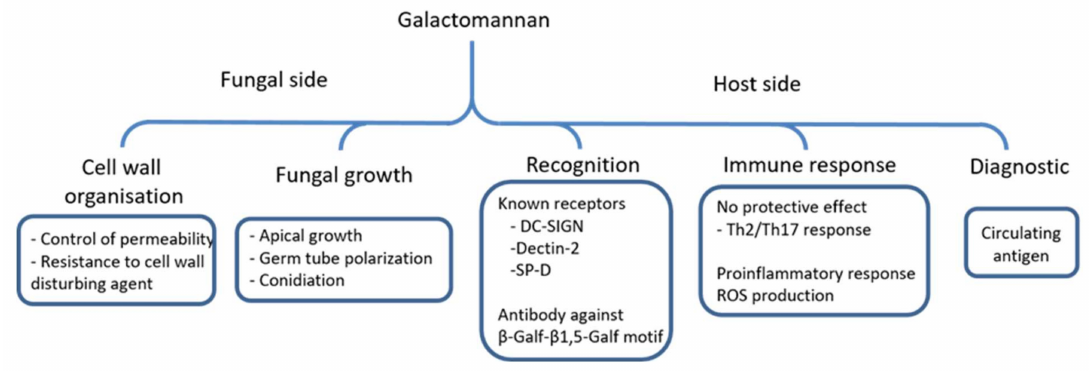
Figure 4. Functions of the GM produced by A. fumigatus . The scheme summarizes biological functions of the GM and its host interaction during